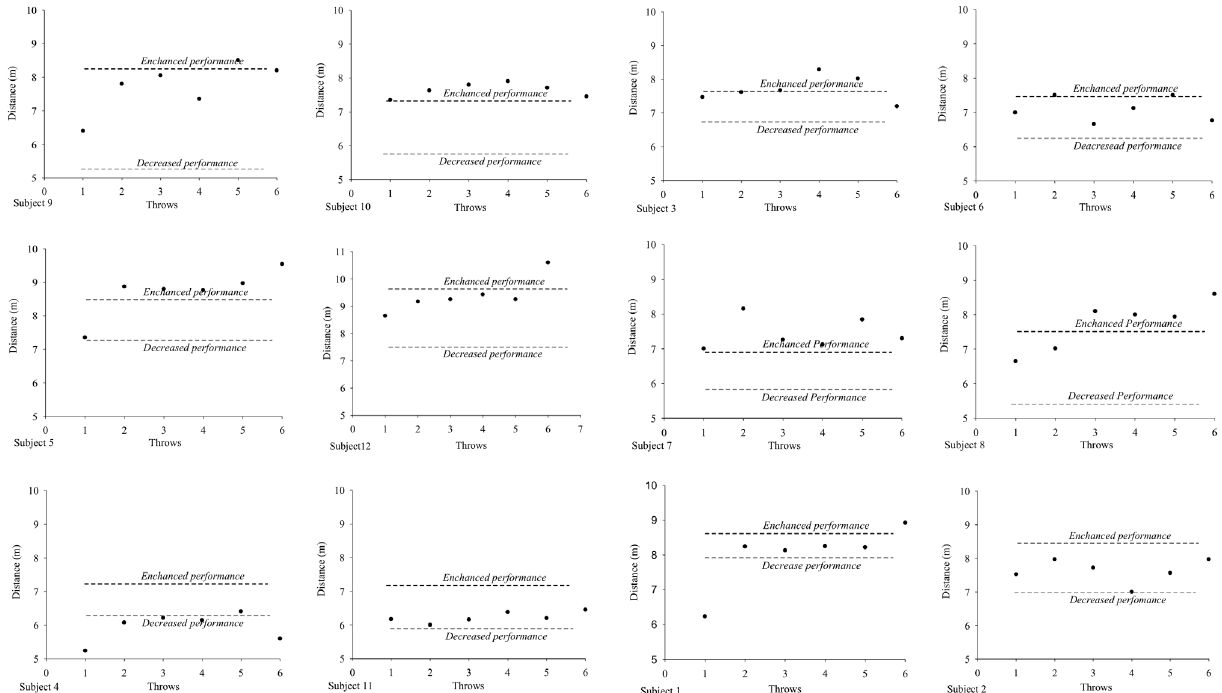
Figure 2. Individual response to the BP protocol. Each point represents a throw. Throws above the upper dashed line represent improved performance while throws below the lower dashed line represent performance worsening. Throws between dashed lines shows that there was no response to